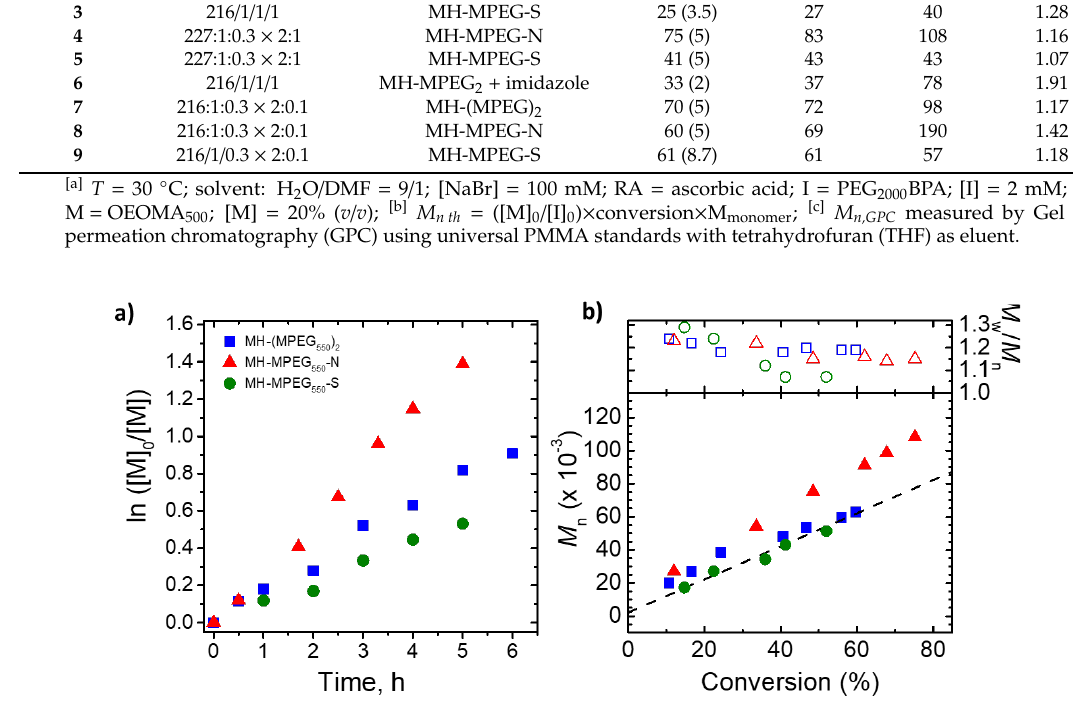
Figure 3. First-order kinetic plots ( a ), evolution of M n and M w / M n with conversion ( b ) for entry 1-3 in Table 1.